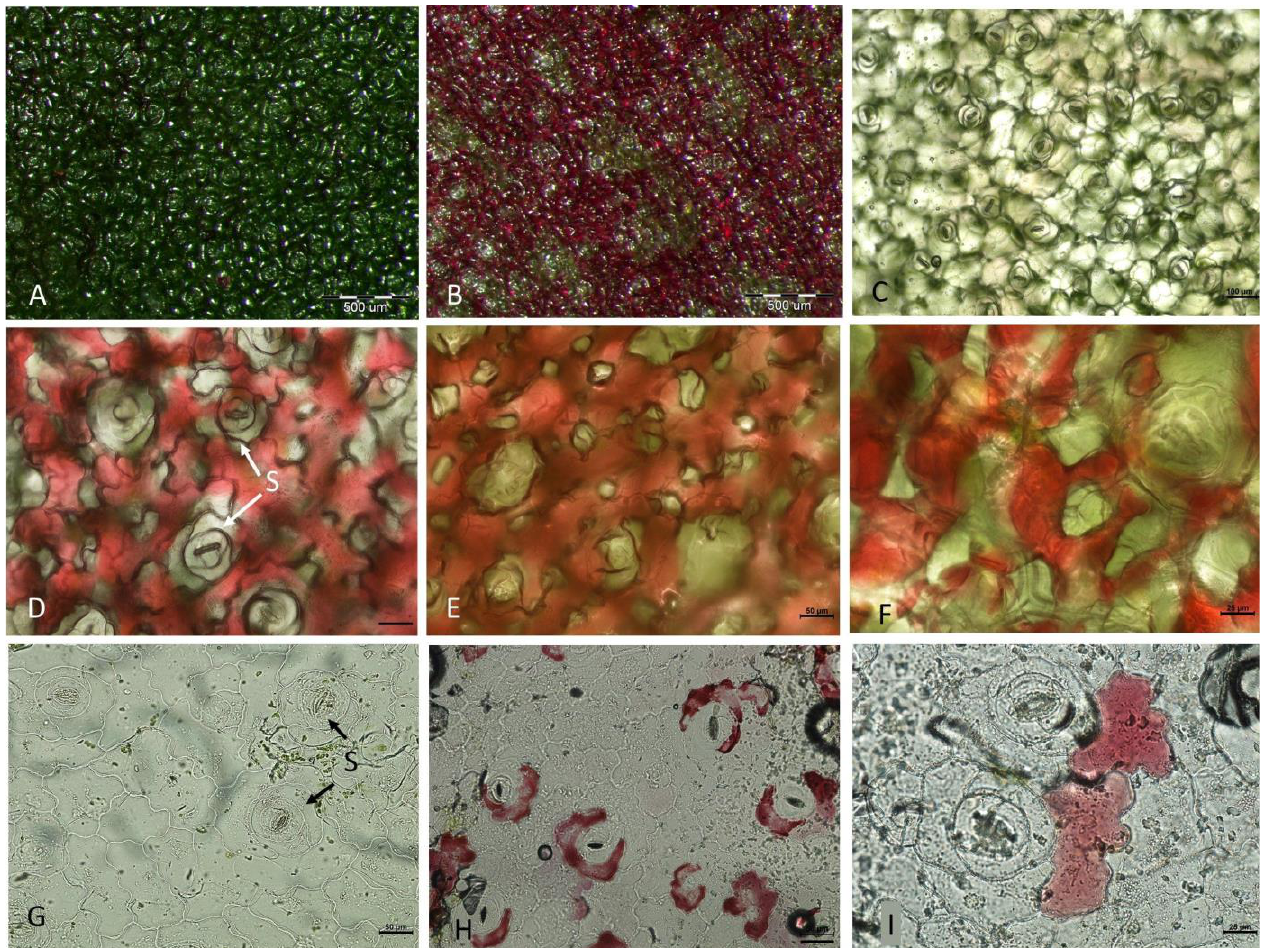
Figure 10. Bright-field microscopy of the leaf surface of K. blossfeldiana . ( A , B ) Detached leaves were kept for 4 days in an inverted position in natural light conditions. ( A ) Adaxial side of the leaf blade. ( B ) Abaxial side of the leaf blade shows a local occurrence of anthocyanins. ( C , G ) Abaxial side of the leaf at day 0 after leaf detachment. ( D – F ) Abaxial side of the leaf kept for 4 days in an inverted position in natural light conditions at higher magnification showing local occurrence of anthocyanins. ( D ) Abaxial surface of leaves without additional interference. ( E , F ) Abaxial surface of leaves after removal of epidermis. ( G ) Abaxial epidermis with stomata isolated from the control leaf. ( H , I ). Abaxial epidermis removed from the leaf was kept for 4 days in an inverted position with local occurrences of anthocyanins. S — stomata. Scar bars: ( A , B ) 500 μm, ( C ) 100 μm, ( D , E , G ) 50 μm, ( F , I ) 25 μm, ( H ) 50 μm.